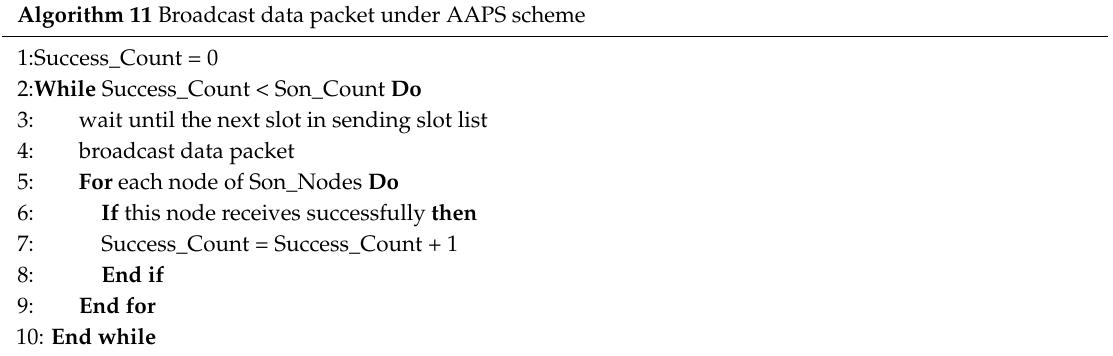
Algorithm 11 Broadcast data packet under AAPS